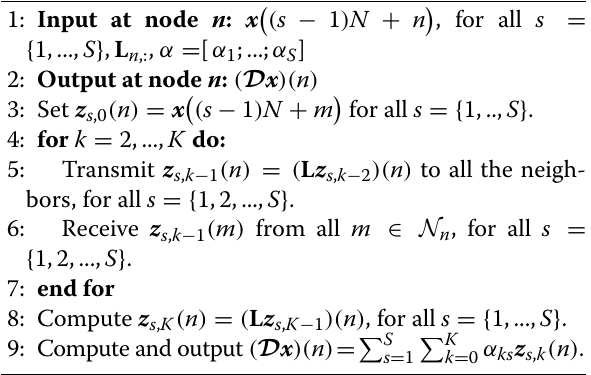
Algorithm 2 Distributed computation of D